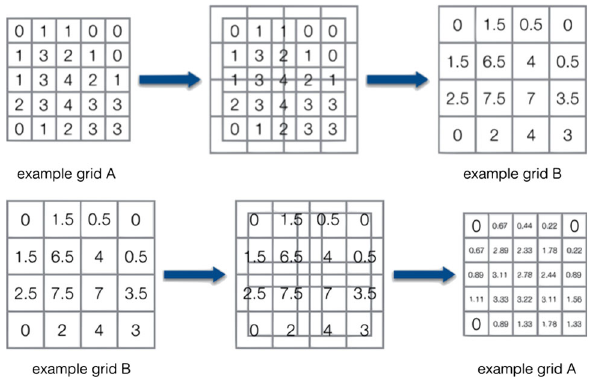
Fig. 16 Example of the resampling procedure used to emulate CLIC data on a different detector geometry (the example shown here is simply a larger grid). First, we extrapolate hit information from one geometry to another (top). Next, we extrapolate back to the original geometry (bottom).Thisallowsustoemulatetheroughergranularityofthesecond geometry, while keeping data array sizes constant and enabling us to use the models we have already developed for the CLIC dataset. Note that some information is lost at the edges